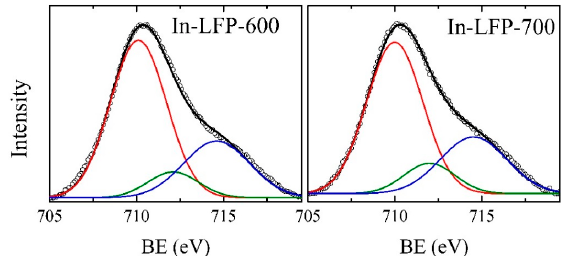
Figure 2. SEM images of ( a ) In-LFP-600 and ( b ) In-LFP-700 samples and their corresponding TEM images ( c , d ). The scale bars in ( a , b ) represent 1 μ m and 100 nm in ( c , d ).